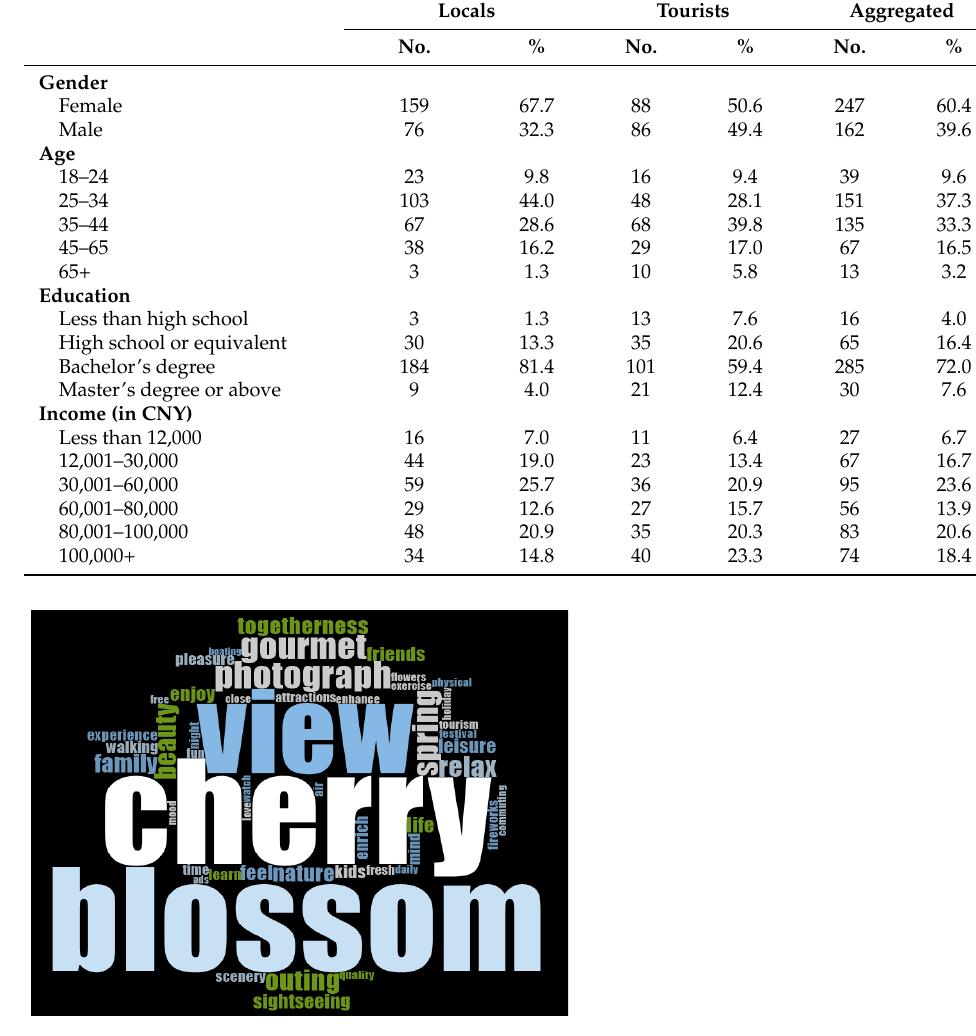
Figure 3. Stated motivations by locals.